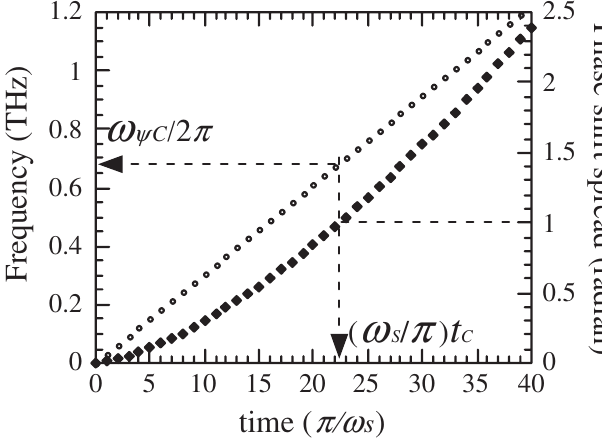
FIG. 1. Evolution of the coherent radiation frequency (open circle) and the phase shift spread (shaded